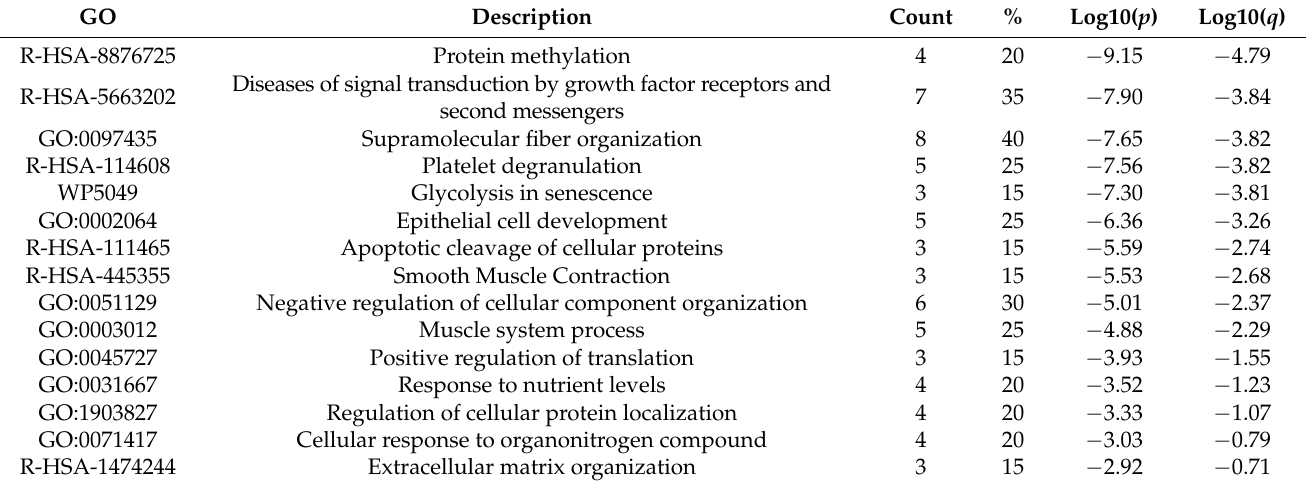
Table 2. Top 15 clusters with their representative enriched terms (one per